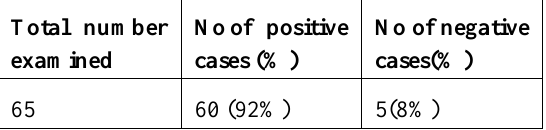
Table 1. Positivity of cutaneous leishmaniasis in examined patients at Khartoum dermatology